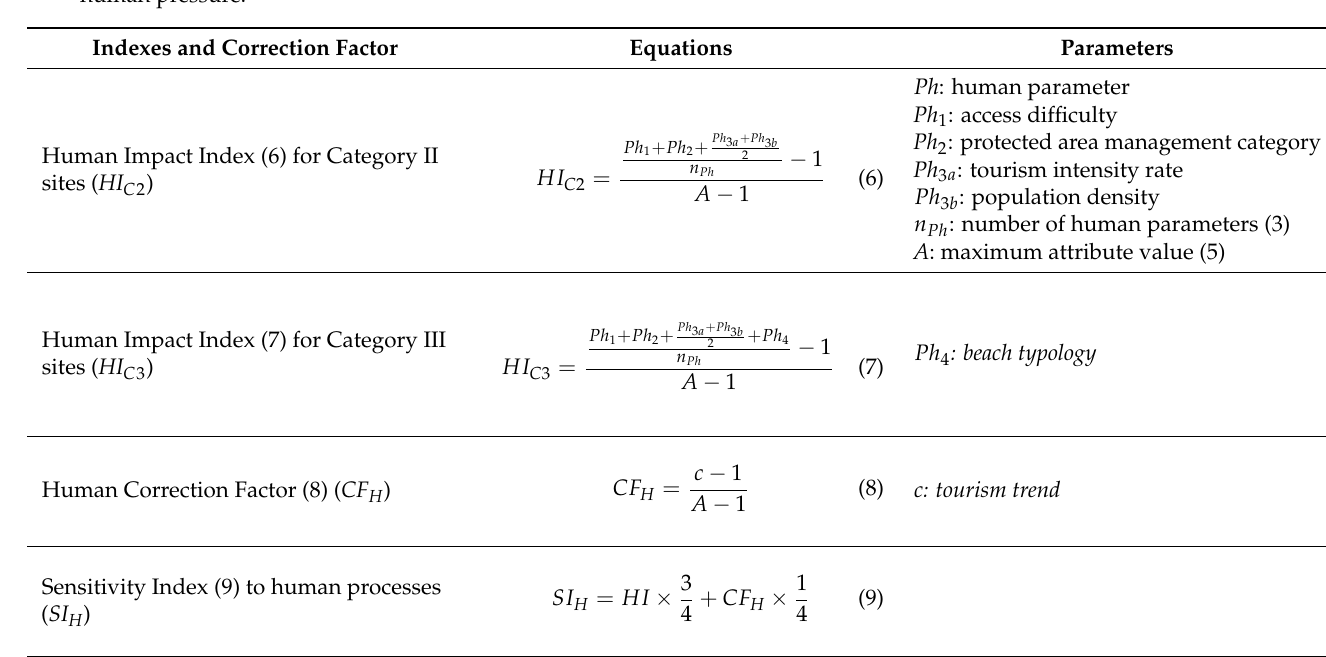
Table 6. Equations regarding Human Impact Index (related to sites categories), Correction Factor and Sensitivity Index to human